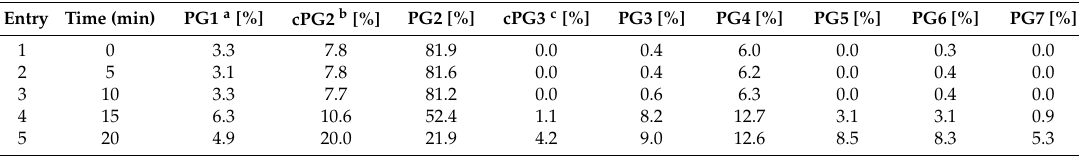
Table 2. Gas chromatography (GC) results for the reaction with diglycerol mixture (96 wt %) as reagent, and K 2 CO 3 (4 wt %) as catalyst, at 300